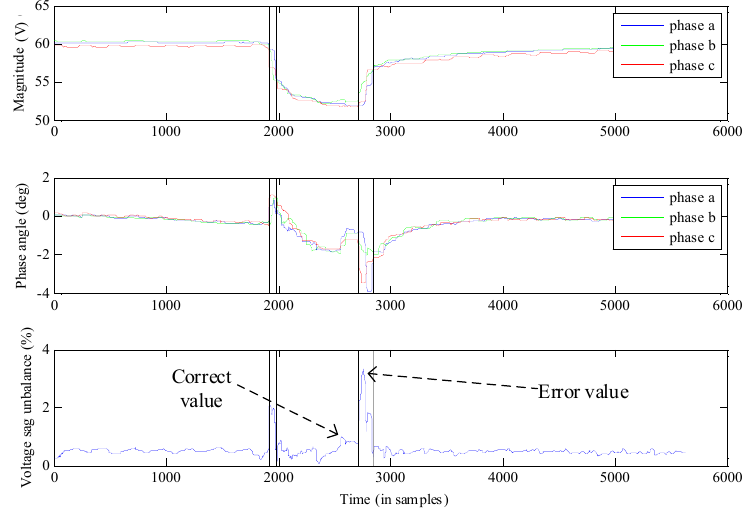
Figure 2. The maximum unbalance value influenced by the transition segment.